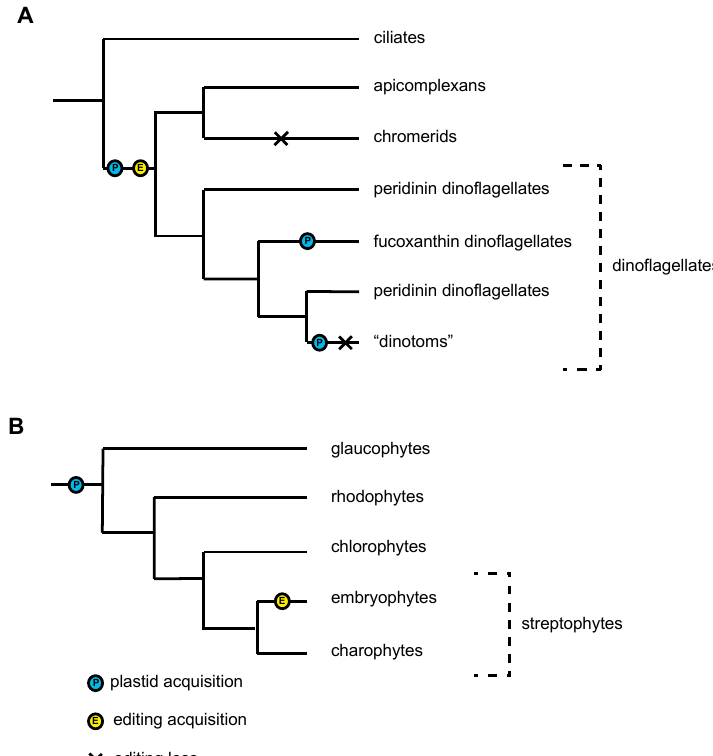
Figure 3. Convergent evolution of RNA editing in plastids. ( A ) RNA editing in the alveolates, including the Apicomplexa and dinoflagellates. There have been two additional plastid acquisitions in dinoflagellates, indicated by the blue Ps: the uptake of a haptophyte-derived plastid in the fucoxanthin dinoflagellates and the uptake of a diatom-derived plastid in the “dinotoms”. The emergence of transcript editing at the base of the Apicomplexa and dinoflagellates is indicated with a yellow E. Dinotoms do not appear to exhibit transcript editing, while the trait has been retained in fucoxanthin dinoflagellates. This trait also does not appear to be present in chromerids, the closest apicomplexan relative with a retained photosynthetic plastid. These losses of transcript editing are indicated with black crosses. ( B ) RNA editing in the Archaeplastida, with the primary endosymbiosis of a cyanobacteria at the base of the clade indicated with a blue P. Restricted (U to C and C to U) RNA editing in this clade appears to be restricted to the land plants, and the emergence of this trait is indicated by a yellow